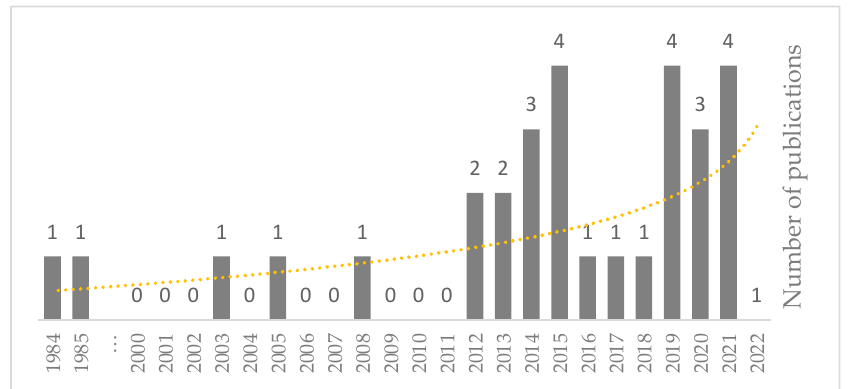
Figure 4. The number of selected studies and overall trend from 1984 to September 2022.